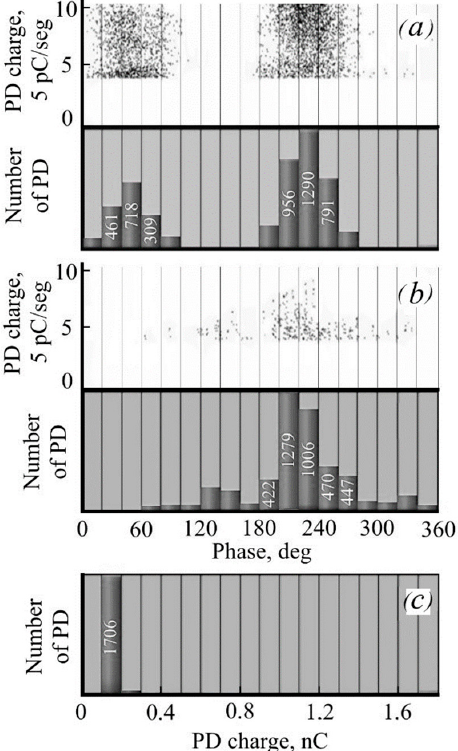
Figure 8. PD characteristics for a workable defect-free insulator No. 3: amplitude–phase characteristics and the dependence of the amount of PD on the phase angle, detected by electromagnetic ( a ) and acoustic ( b ) sensors; ( c ) distribution of the number of PDs detected by the electromagnetic sensor, depending on the intensity.